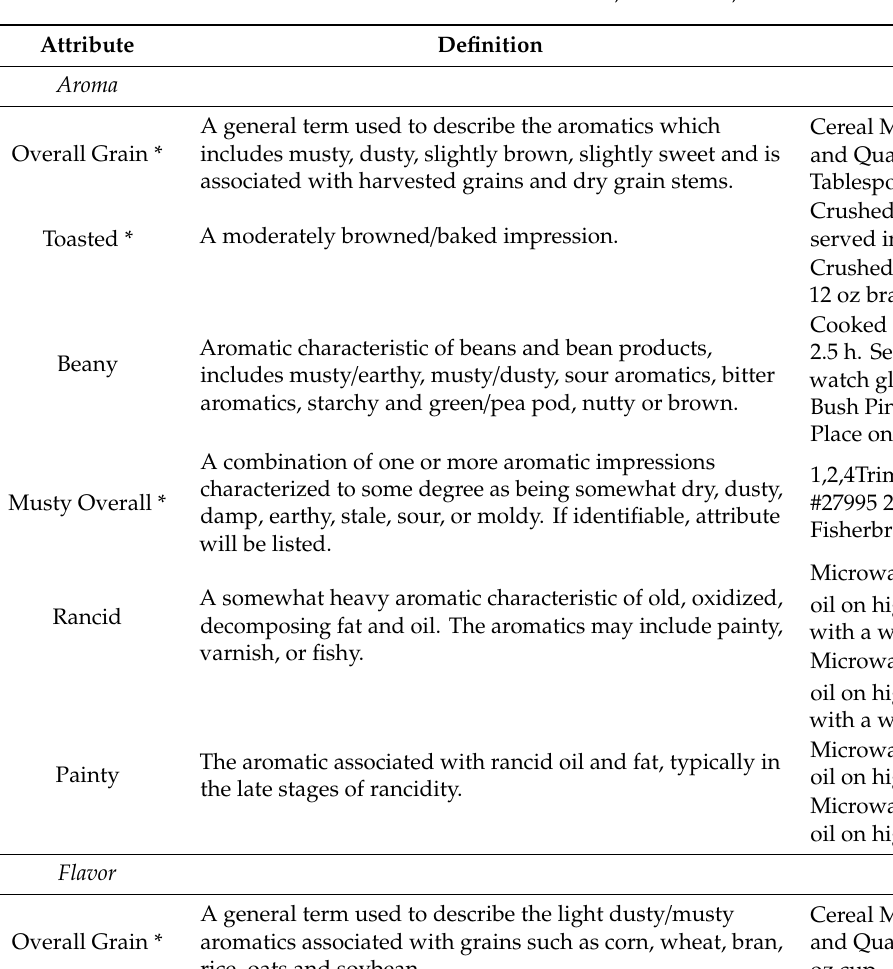
Table 3. Aroma and flavor attributes, definitions, and references for descriptive analysis of porridge prepared from